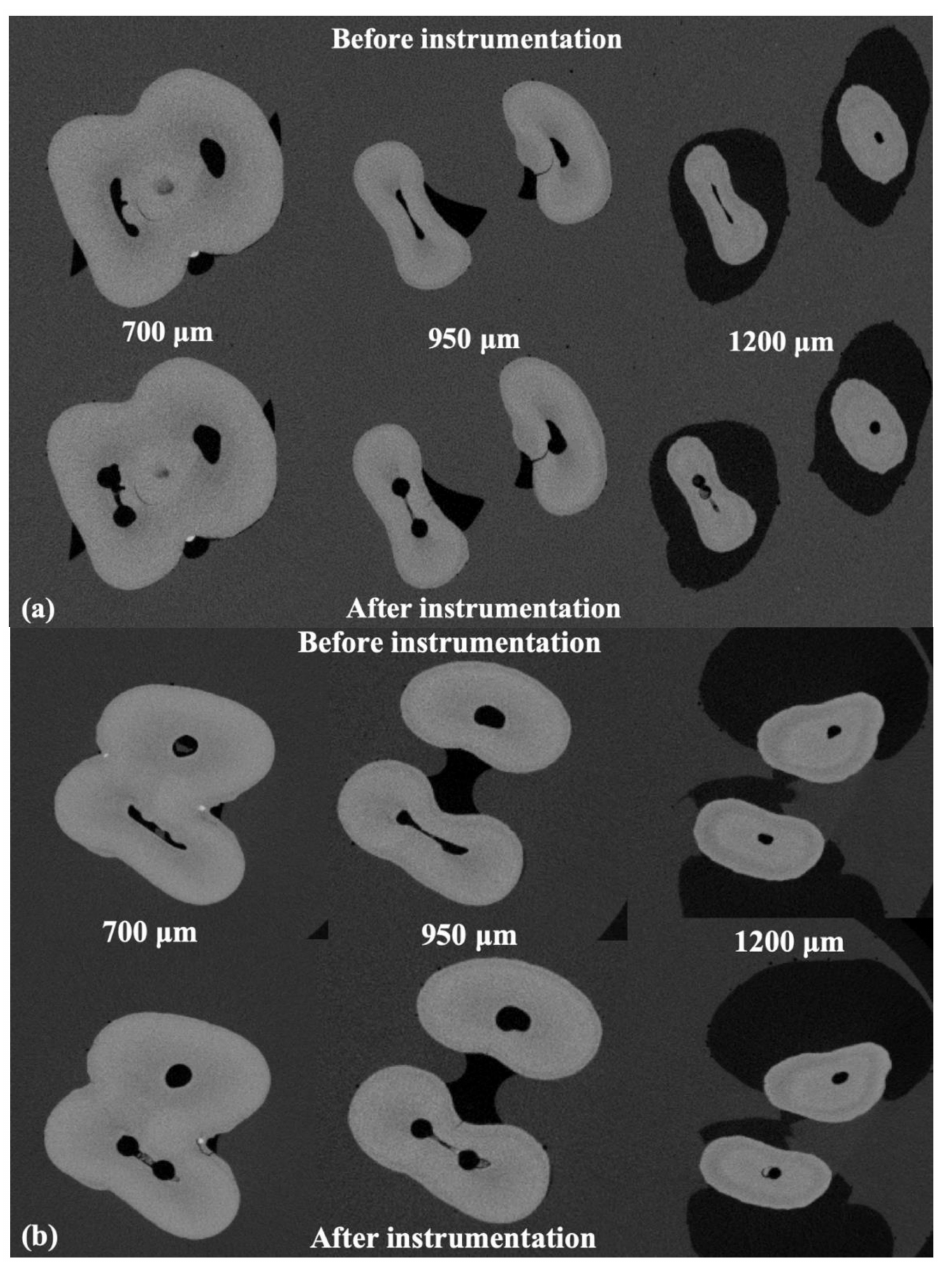
Figure 2. ( a ) Cross-section images from different level slices 700 µ m (top), 950 µ m (middle), and 1200 µ m (bottom) obtained from micro-CT image before (images on the left) and after (images on the right) root canal preparation using TF system. ( b ) Cross-section images from deferent level slices 700 µ m (top), 950 µ m (middle), and 1200 µ m (bottom) obtained from micro-CT image before (images on the left) and after (images on the right) root canal preparation using BioRace